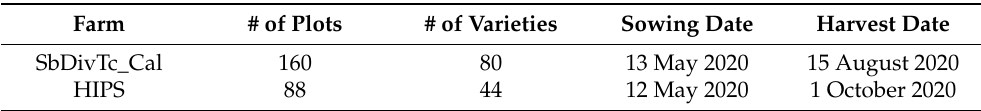
Figure 1. Plot variety layout: ( a ) SbDivTc calibration panel and ( b ) HIPS. Table 1. Experimental